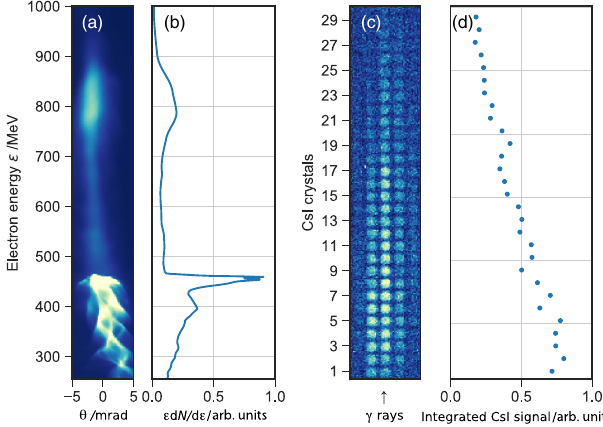
FIG. 2. (a) Electron spectrometer screen image, transformed onto a linear energy axis. (b) Angularly integrated electron spectrum. (c) Raw image of CsI crystal stack detector. (d) Inte- grated CsI signal as a function of penetration depth into the stack.